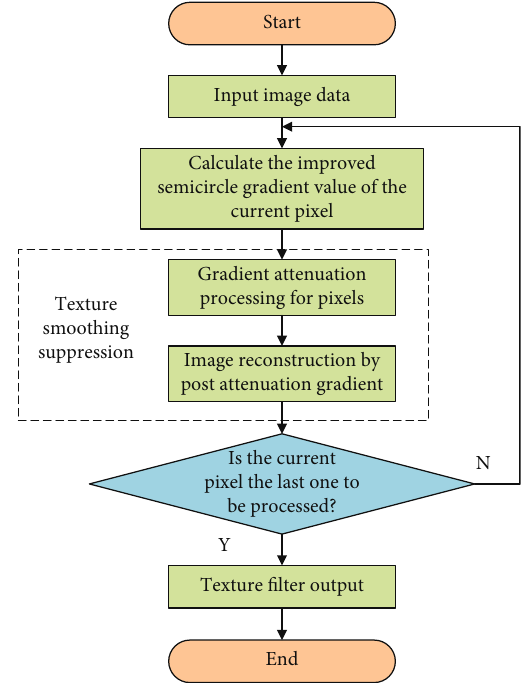
Figure 4: Flow of fi ltering algorithm combining texture smoothing suppression and circular